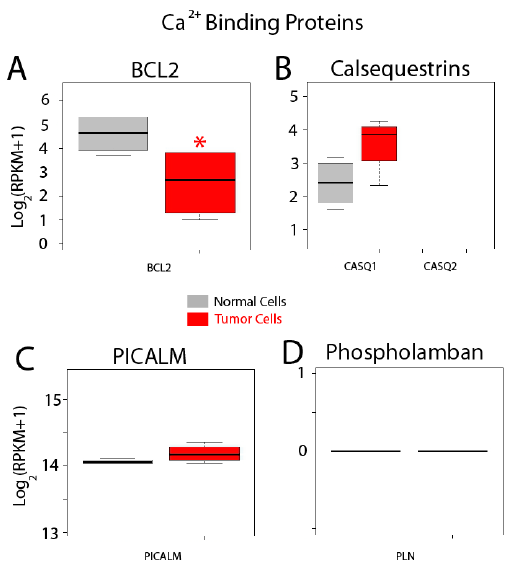
Figure 14. Expression of selected genes coding for other selected proteins. Expression levels of BCL2 , ( A ) calsequestrins CASQ1 and CASQ2 ( B ), PICALM ( C ) and PLN (Phospholamban) ( D ) in normal colonic cells (grey bars) and colon cancer cells (red bars). * p statistically significant by three independent methods.